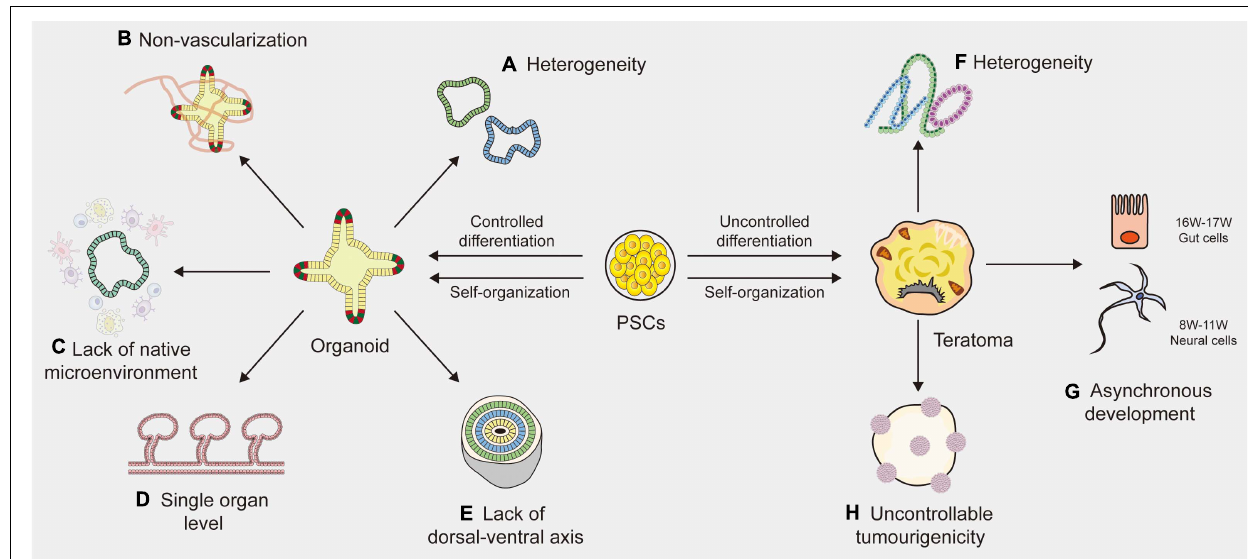
FIGURE 1 | Limitations of organoid and teratoma. (A) Due to the lack of a reliable way to synchronize the size, shape and survival of organoids, the organoids vary among different laboratories. (B) The absence of blood vessels in organoids impedes their maturation and function. (C) Organoids lack native microenvironment which impede their applications in disease modeling and drug screening. (D) Most organoids are based on the single organ level and merely imitate a small part of the human body, not the entire part. (E) The absence of a continuous anterior-posterior or dorsal-ventral axis that guides and supports proper organoid directionality, especially for cerebral organoids. (F) Cell proliferation and differentiation are affected and controlled by cell lineages, host types and graft sites, resulting in the heterogeneity of teratomas. (G) The development of teratomas is asynchronous. In the 10-week teratoma, neural cells were highly similar to prefrontal cortex cells at human gestational weeks 16–17, while gut cells were most similar to human gut cells at gestational weeks 8–11. (H) The tumorigenicity of PSCs (pluripotent stem cells) is uncontrollable, leading to the uncontrollable tumorigenicity of